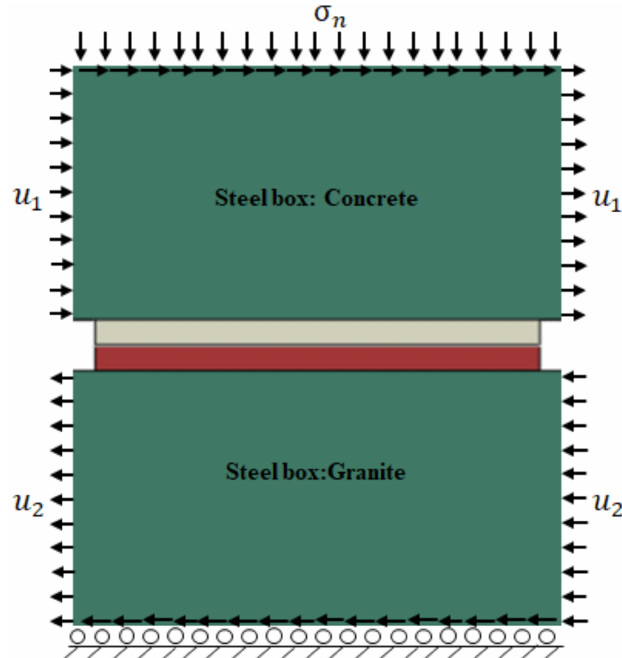
Figure 18. Boundary conditions—bush-hammered interface.